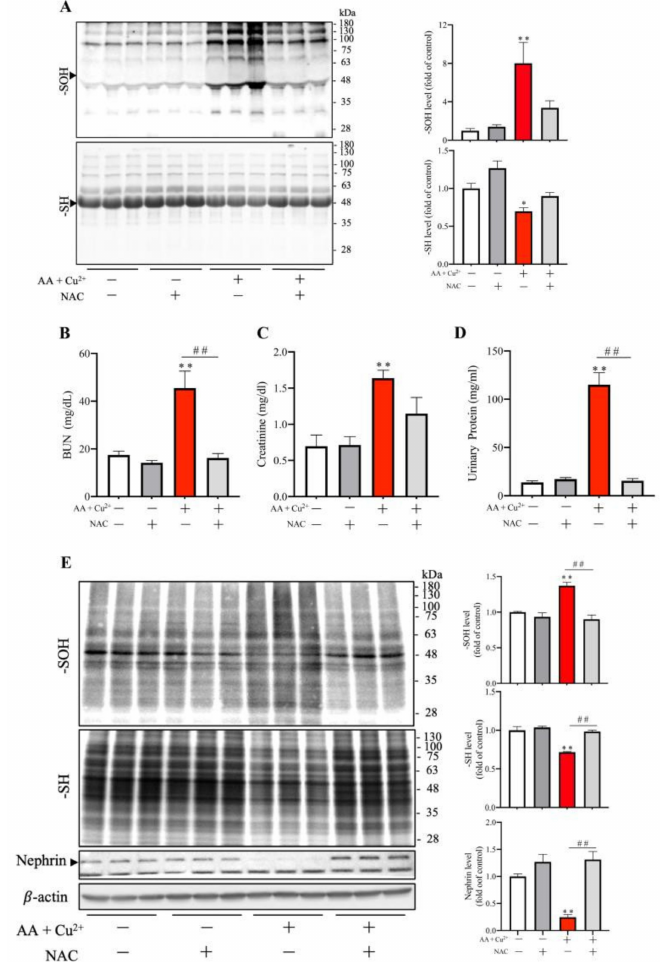
Figure 7. Prevention of AA and Cu 2+ -induced systemic oxidative stress and renal injury by antioxi- dant NAC. Mice were intraperitoneally injected with 200 mg/kg NAC at 12-h intervals for 6.5 days. AA (1000 mg/kg) plus Cu 2+ (1 mg/kg) were administered 12 h after the initial NAC injection via gavage once per day for six days. Serum proteins were analyzed for the level of -SH groups and -SOH formation ( A ). The densitometric quantitation of the bands around 50~60 kDa (arrowhead) was performed and presented as the bar graph on the right side of the blot. Data shown are mean ± SE ( n = 3; * p < 0.05; ** p < 0.01 vs. control). BUN, creatinine and urinary protein levels were measured ( B – D ). Data shown are mean ± SE ( n = 4; ** p < 0.01 vs. control, ## p < 0.01). The level of -SOH/-SH and nephrin in kidney lysates was detected ( E ). The densitometric analysis of the band in each lane is shown on the right side of the blot. Data shown are mean ± SE ( n = 3, ** p < 0.01 vs. control; ## p <